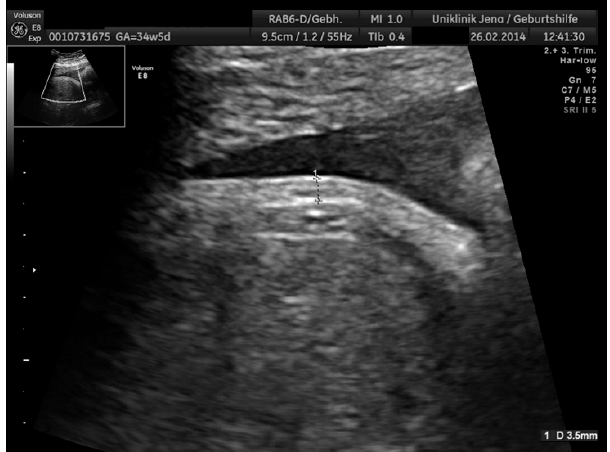
Figure 1. Ultrasound images showing fetal abdominal subcutaneous tissue (FAST) measurement of 3.5 mm at 35 weeks of gestation using Bethune’s method [18].